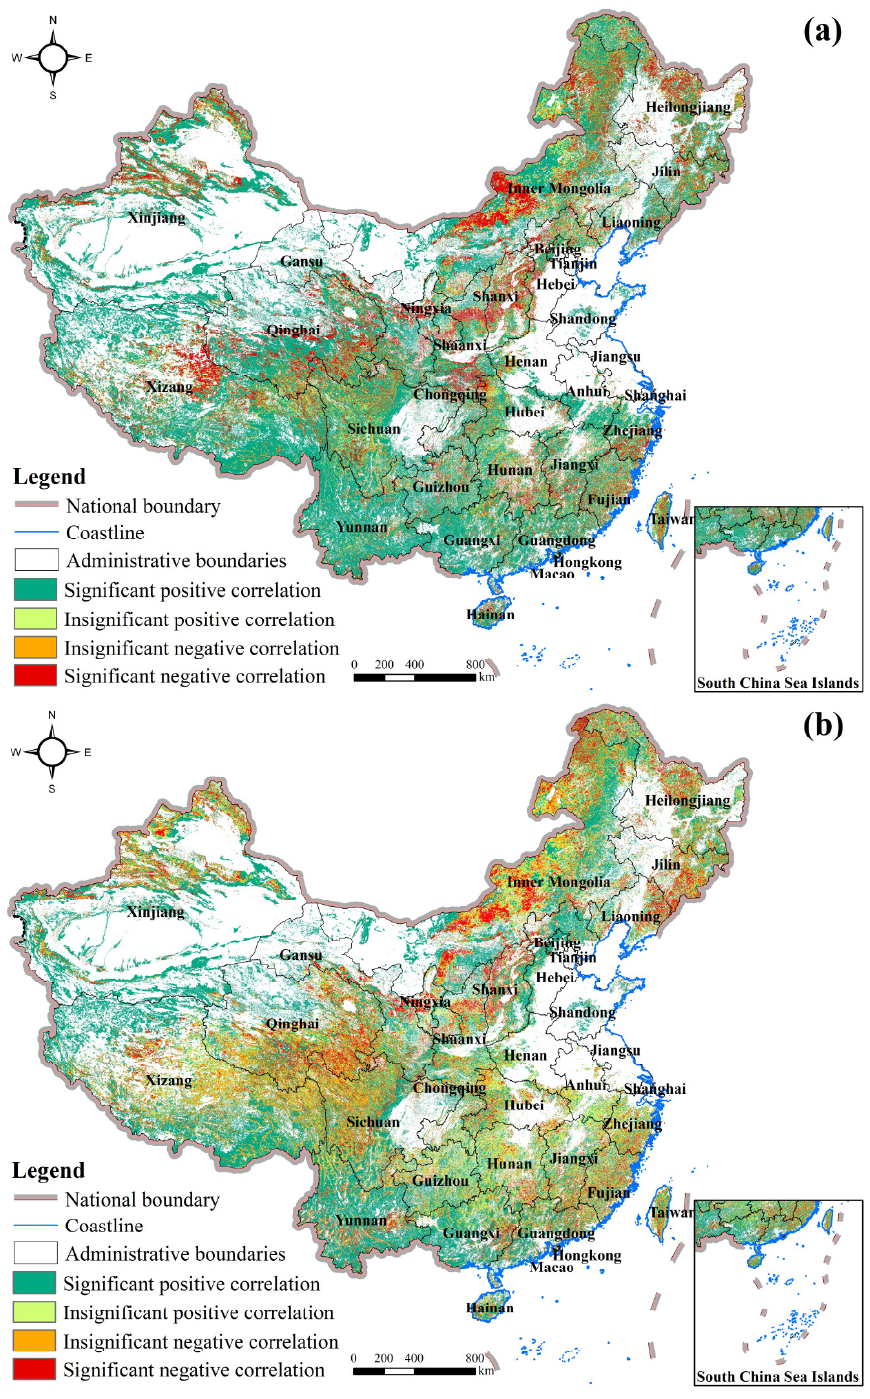
Figure 11. Partial correlation of CS in CES with ( a ) temperature and ( b ) precipitation.